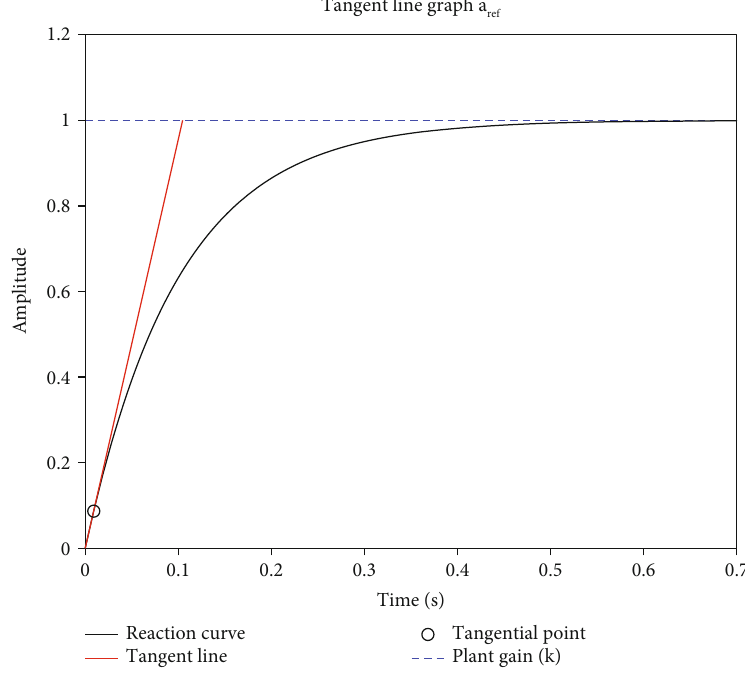
Figure 11: Reaction curve or a